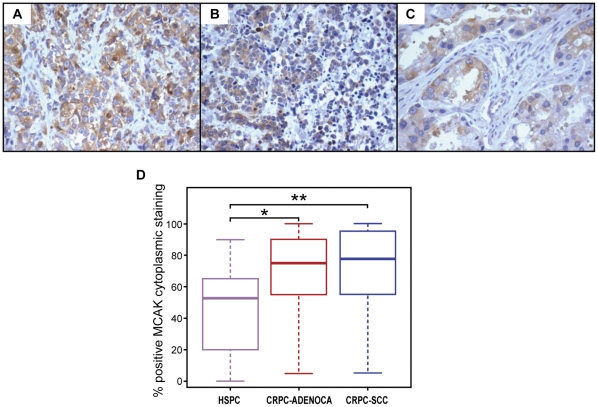
Overexpression of MCAK with clinical progression of prostate cancer.
MCAK-immunostained sections of castration-resistant adenocarcinoma (A), castration-resistant small cell carcinoma (B), and hormone-sensitive prostate carcinoma (C). D) Significantly increased labeling for the mitotic centromere-associated protein MCAK with progression to CRPC, indicated by asterisks.